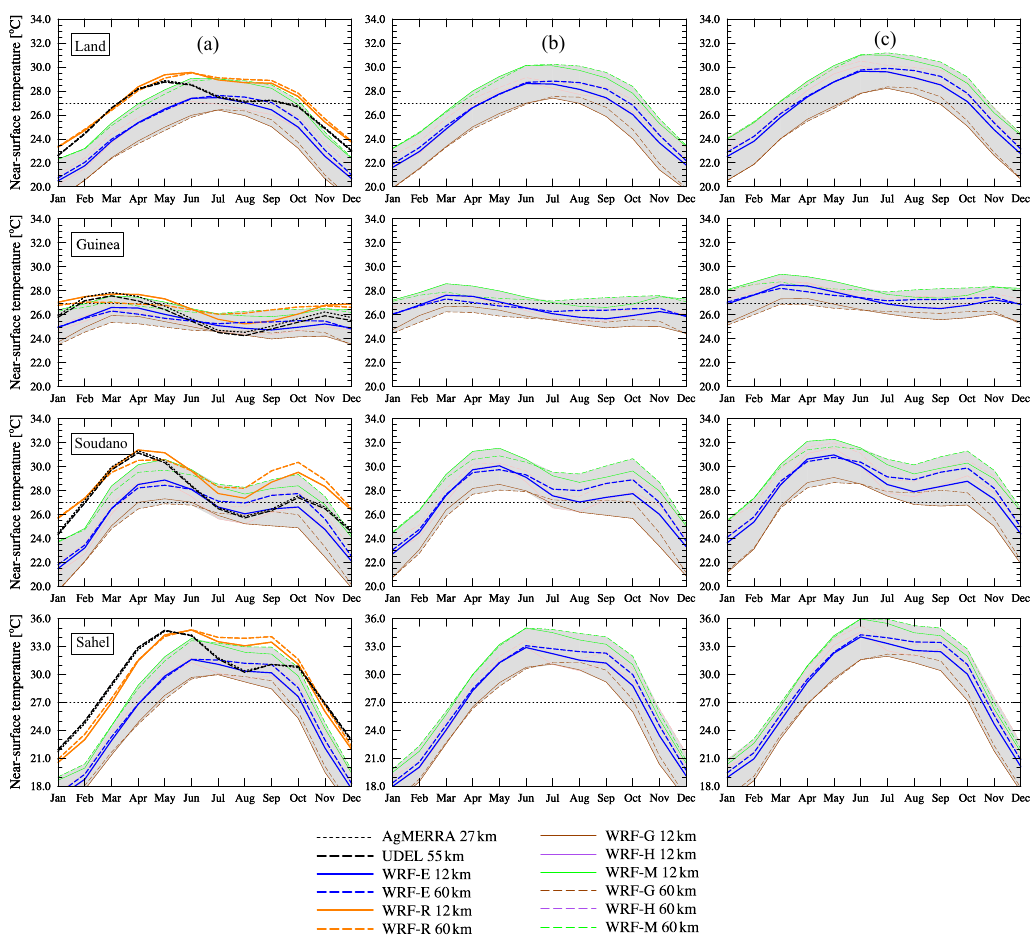
Figure 2. Annual cycle of near-surface temperature for the historical period 1980–2010 (a) , the near future 2020–2050 (b) , and the end of the 21st century 2070–2100 (c) , averaged over all land area and for the different regions displayed in Fig. 1. WRF-R: ERA-Interim control run; WRF-M: MPI-ESM-MR historical run; WRF-H: HadGEM2-ES historical run; WRF-G: GFDL-ESM2M historical run; WRF-E: multi-model ensemble of WRF-M, WRF-H and WRF-E. The shaded areas encompass the entire spread of the 12 and 60km members of the multi-model